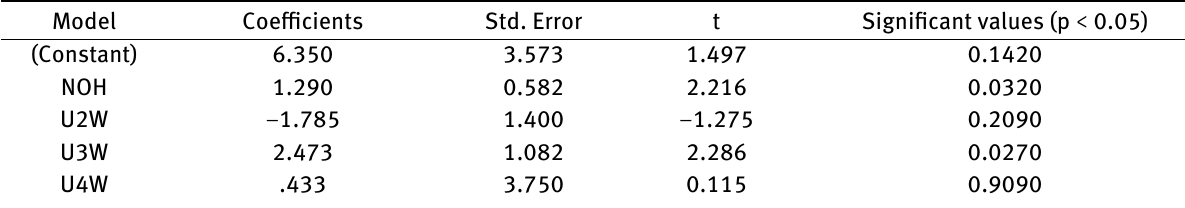
Table 6: Regression variable results for 4 hours Model